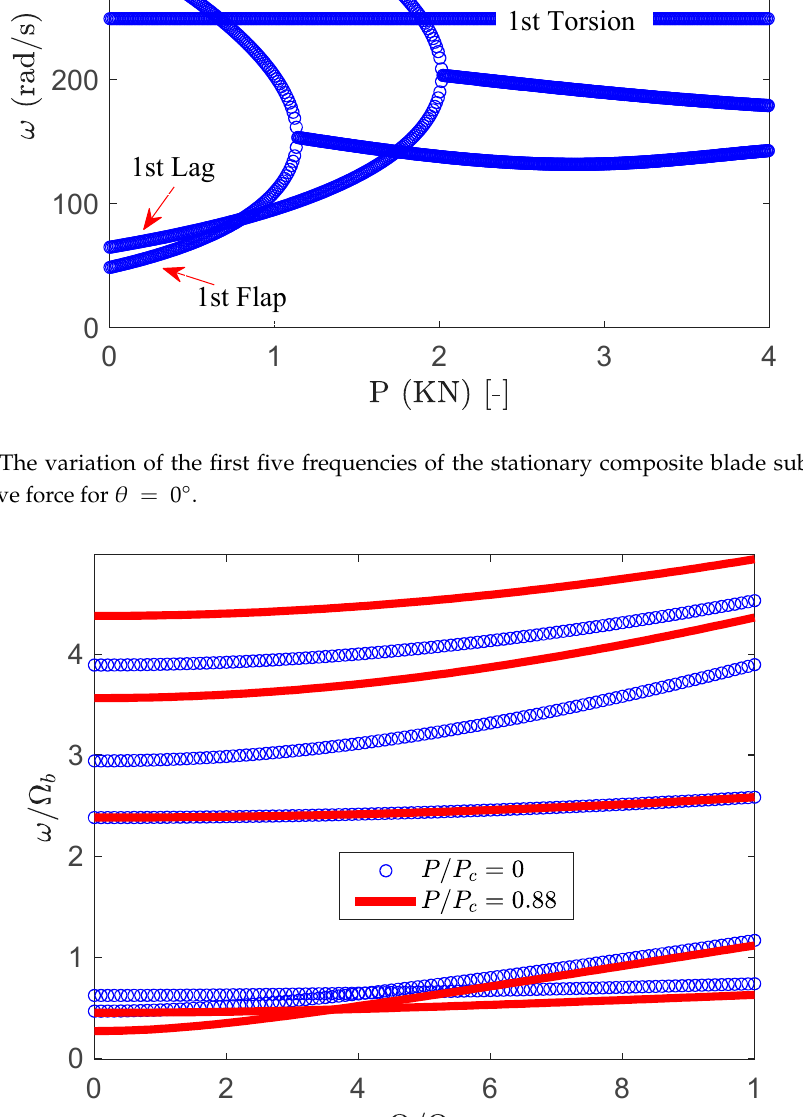
Figure 3. The variation of the first five frequencies of the stationary composite blade subjected to compressive force for θ = 0 o .